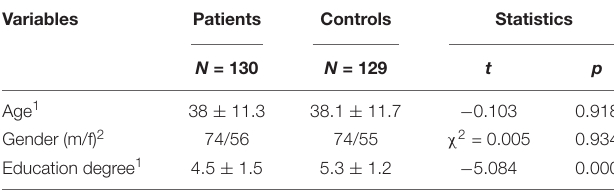
TABLE 1 | Demographic data from patient and control